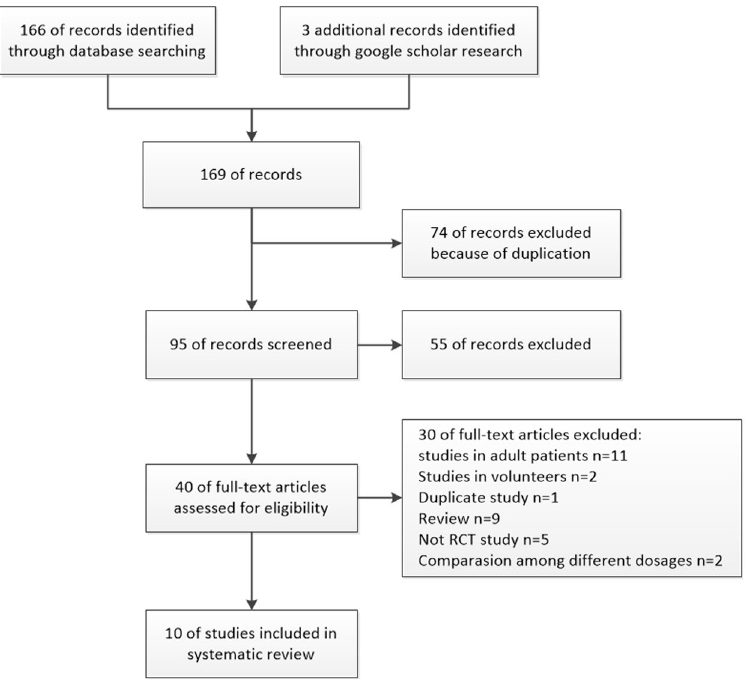
Figure 1. Study selection flow